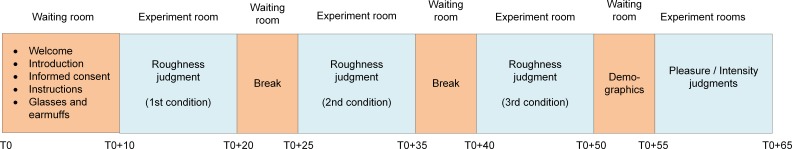
Schematic representation of the procedure.